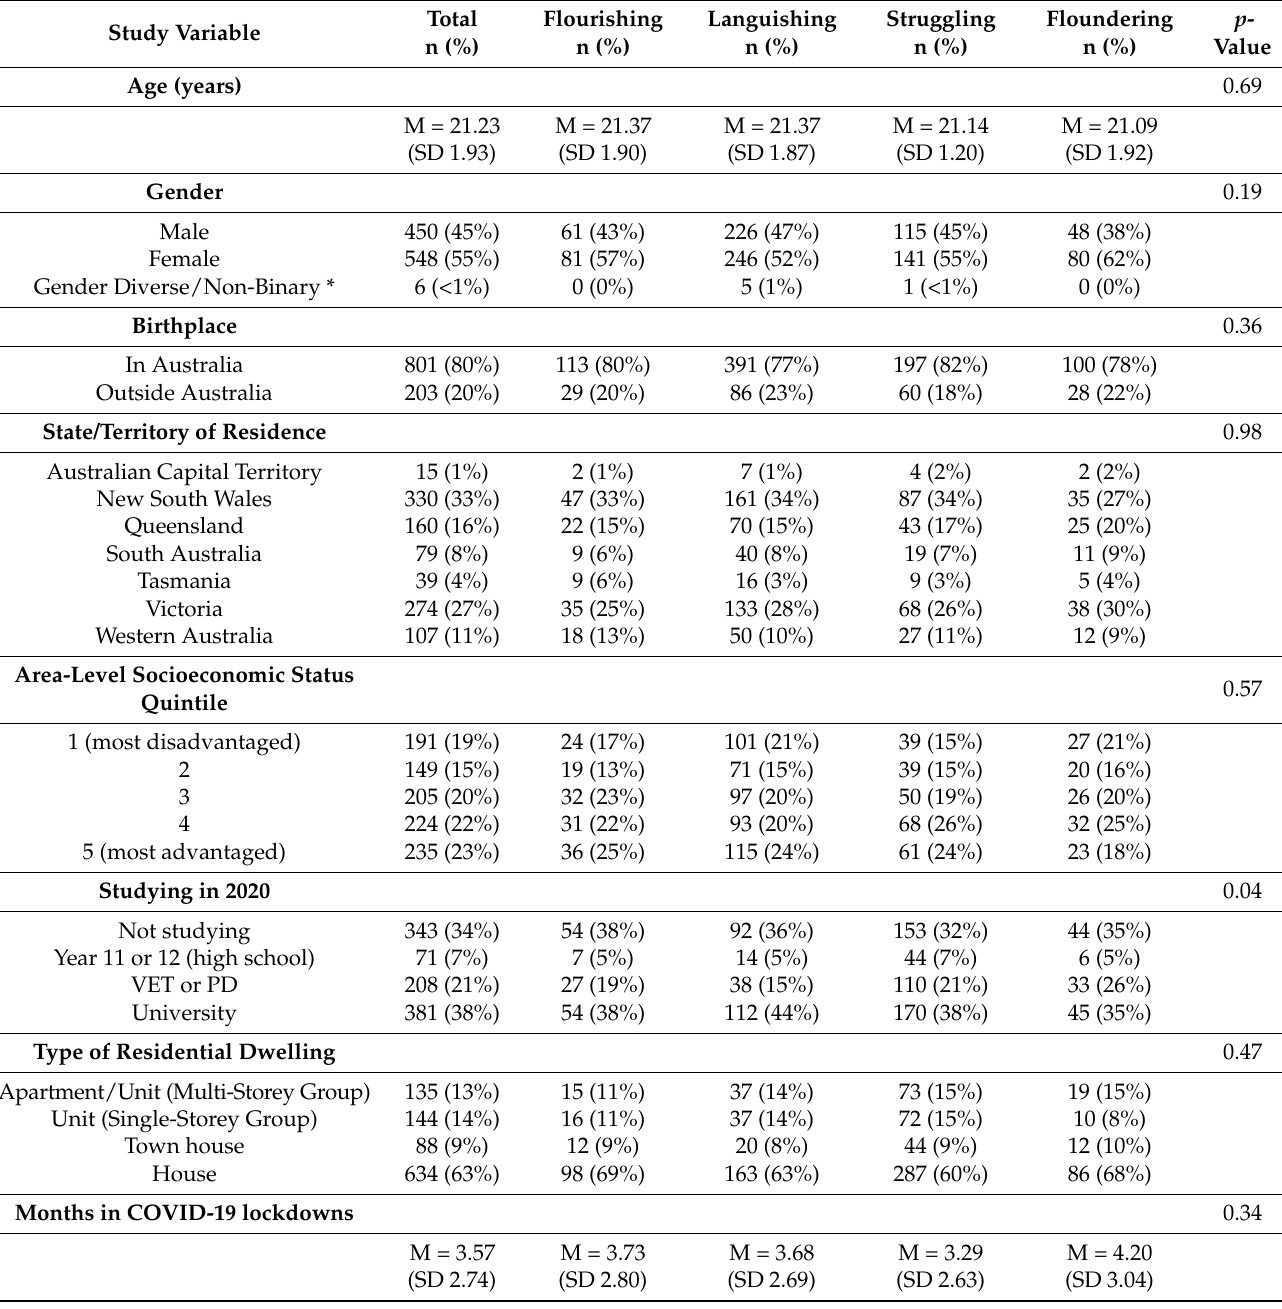
Table 2. Sociodemographic variables by mental health